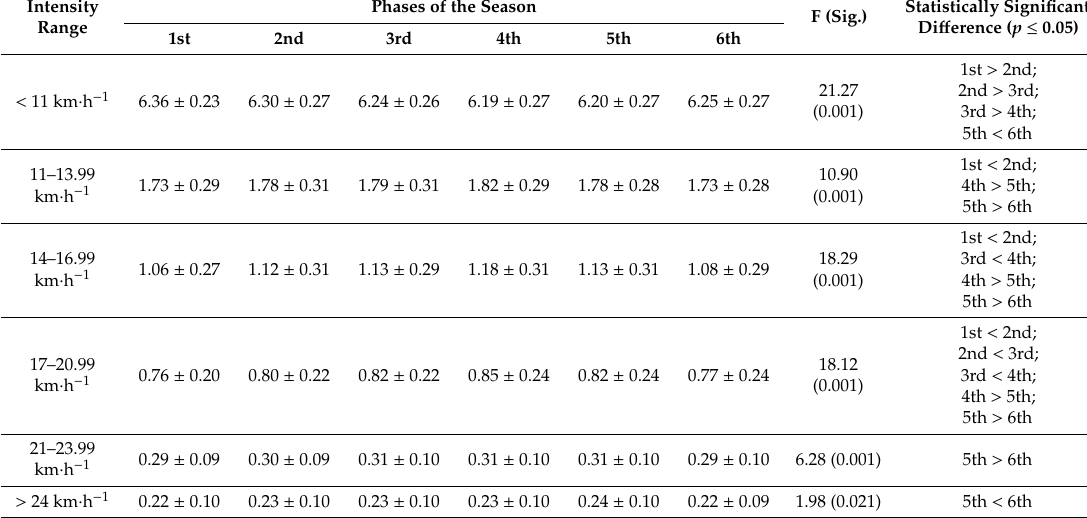
Table 1. Di ff erences in [km] distances covered at di ff erent intensities by soccer players in the Bundesliga, with regard to phases of the season (mean ± SD). Intensity Phases of the Season F (Sig.) Range